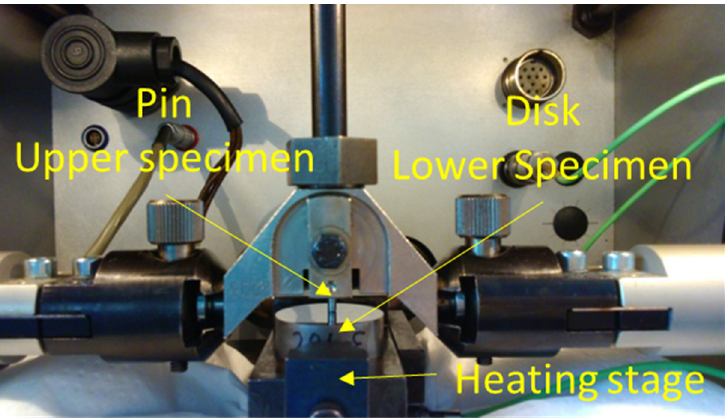
Figure 3. Upper and lower specimens in the SRV machine.